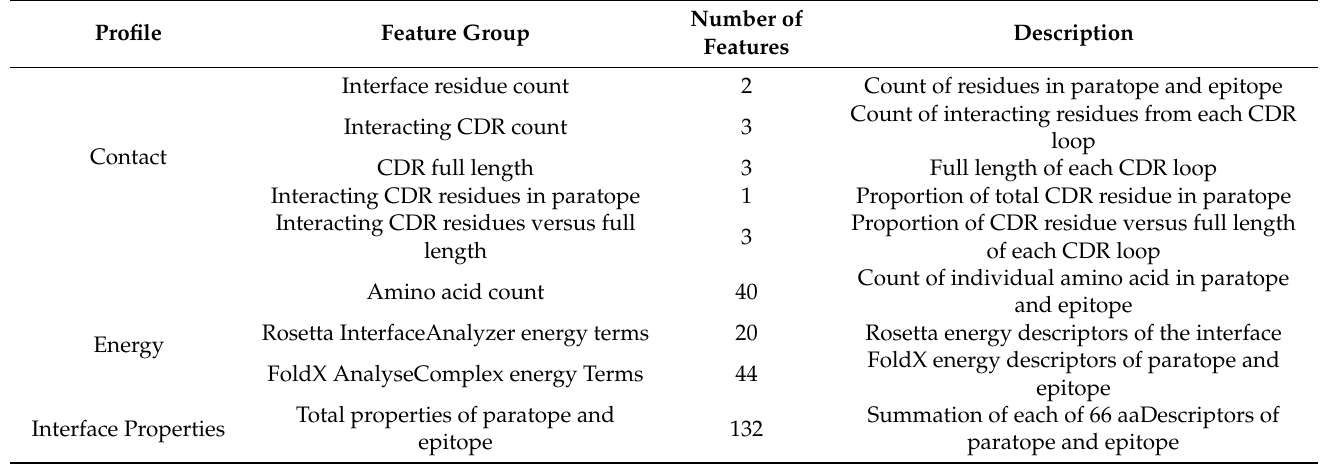
Table 2. Description of individual feature groups of the feature set.